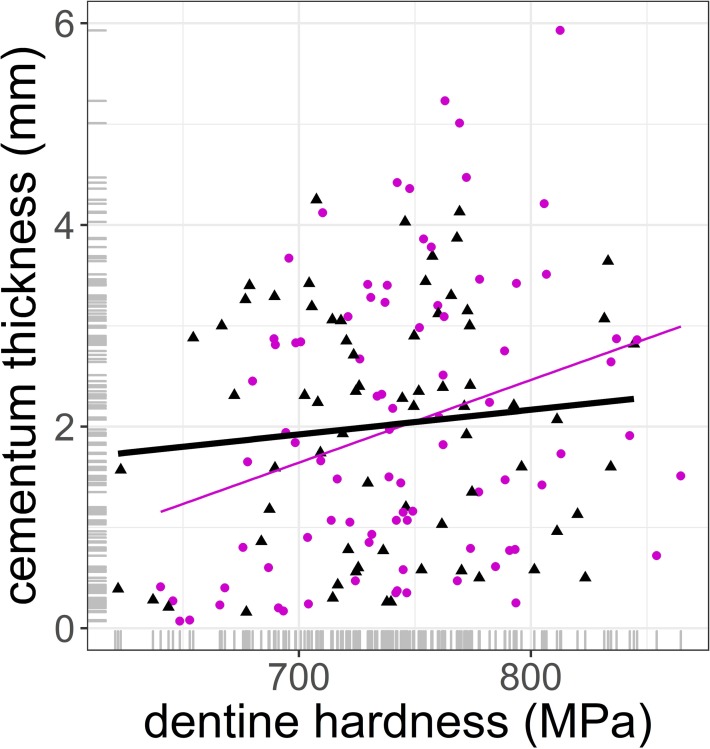
Prediction of inter-radicular cementum thickness pad (in mm) against dentine micro-hardness (in mega Pascal) using the model in Table 5.Circle and purple thin line: female; triangle and black thick line: male. No significant differences in slope and intercept between sexes. Details in Table 2.